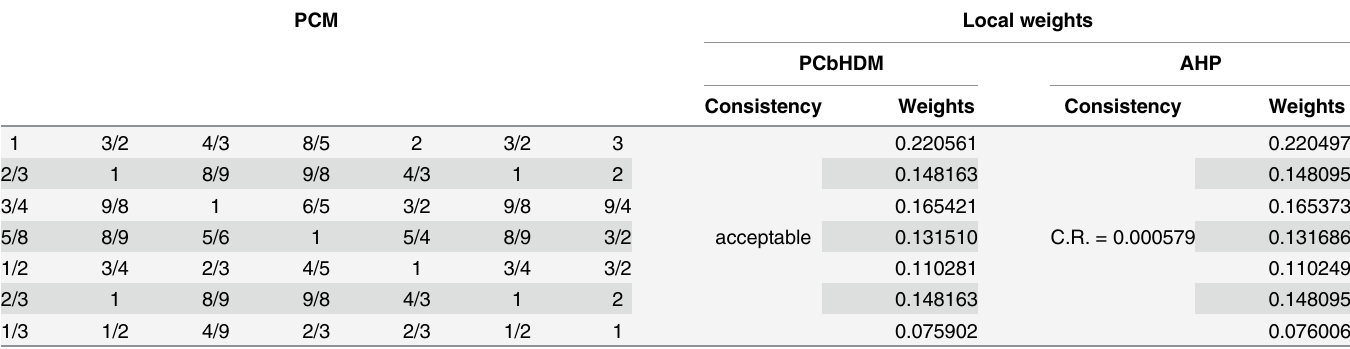
Table 2. PCM of criteria with respect to the goal and local weights. PCM Local weights PCbHDM AHP Consistency Weights Consistency Weights